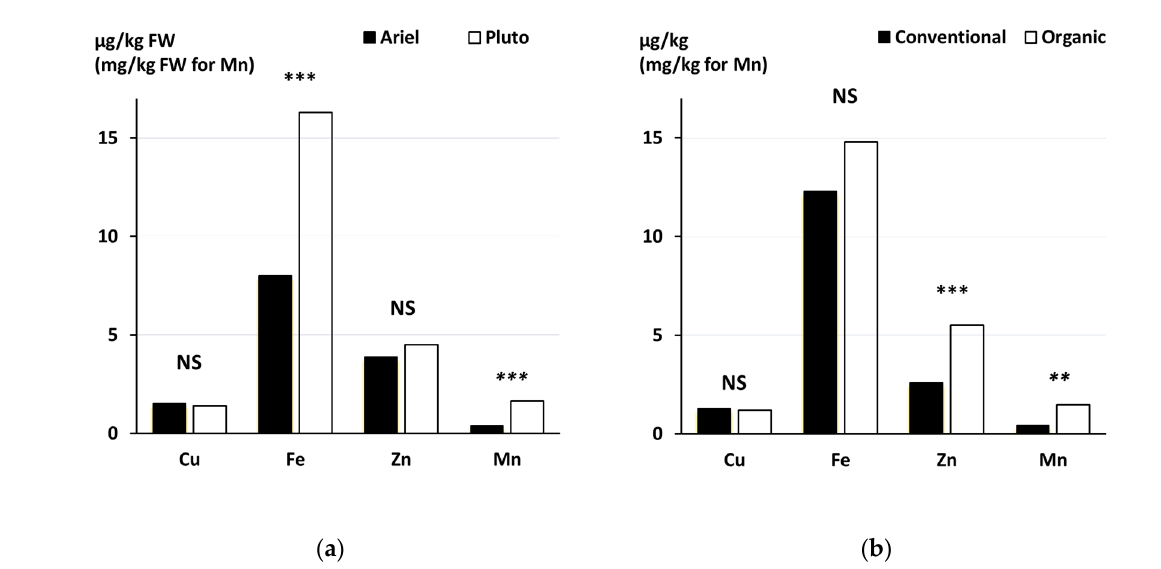
Figure 11. Effect of different F1-hybrid (Ariel F1 versus Pluto F1) and production systems (conventional vs organic) on mineral micronutrient concentrations (Cu, Fe, Zn, Mn) in butternut squash (values shown are main effect means; results are from a single field experiment in Spain; data from [159]. *** significant difference ( p < 0.001); ** significant difference ( p < 0.01); NS, not significant.